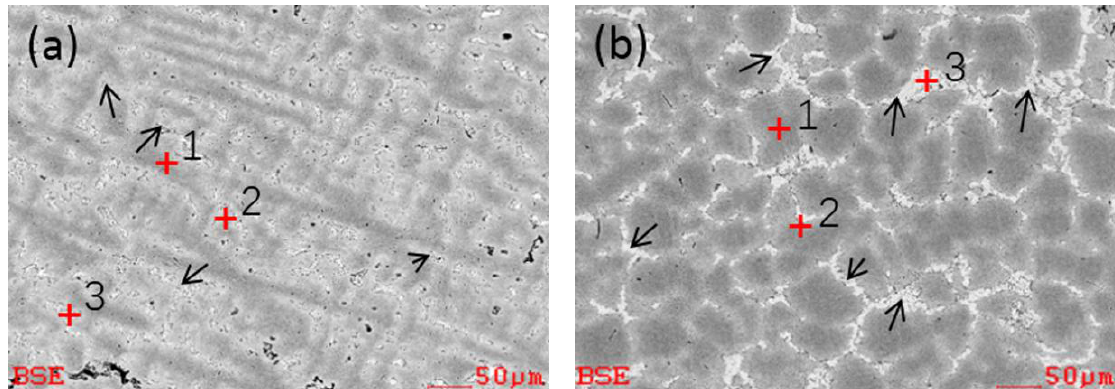
Figure 6. SEM micrograph of ZCuSn10P1 alloy: ( a ) as-cast; and ( b ) semi-solid.